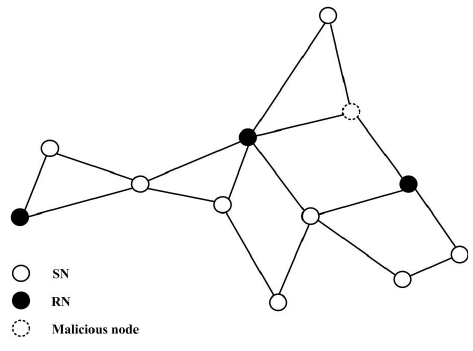
Figure 1. A network with eight honest sensor nodes, three relay nodes and one attacker.